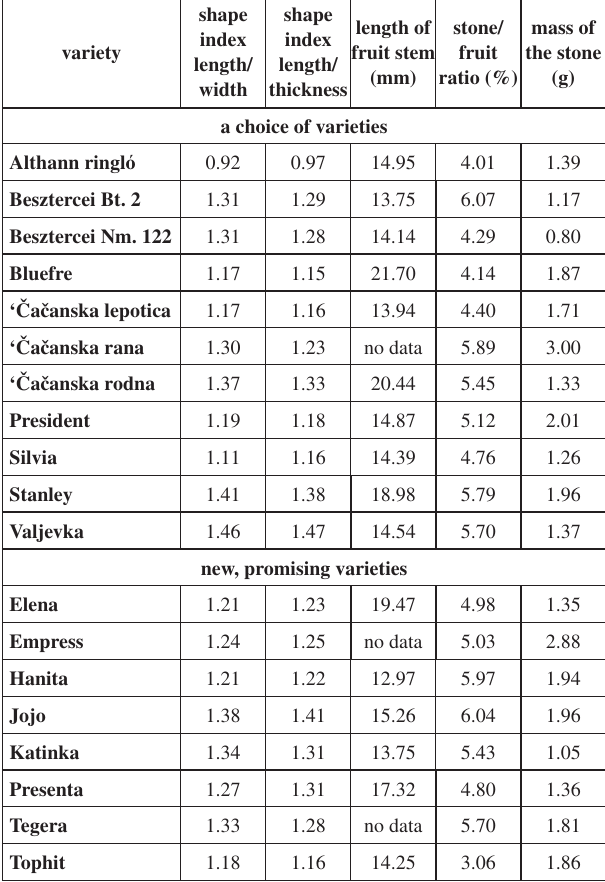
Table 3. Main physical and chemical properties of plum fruits